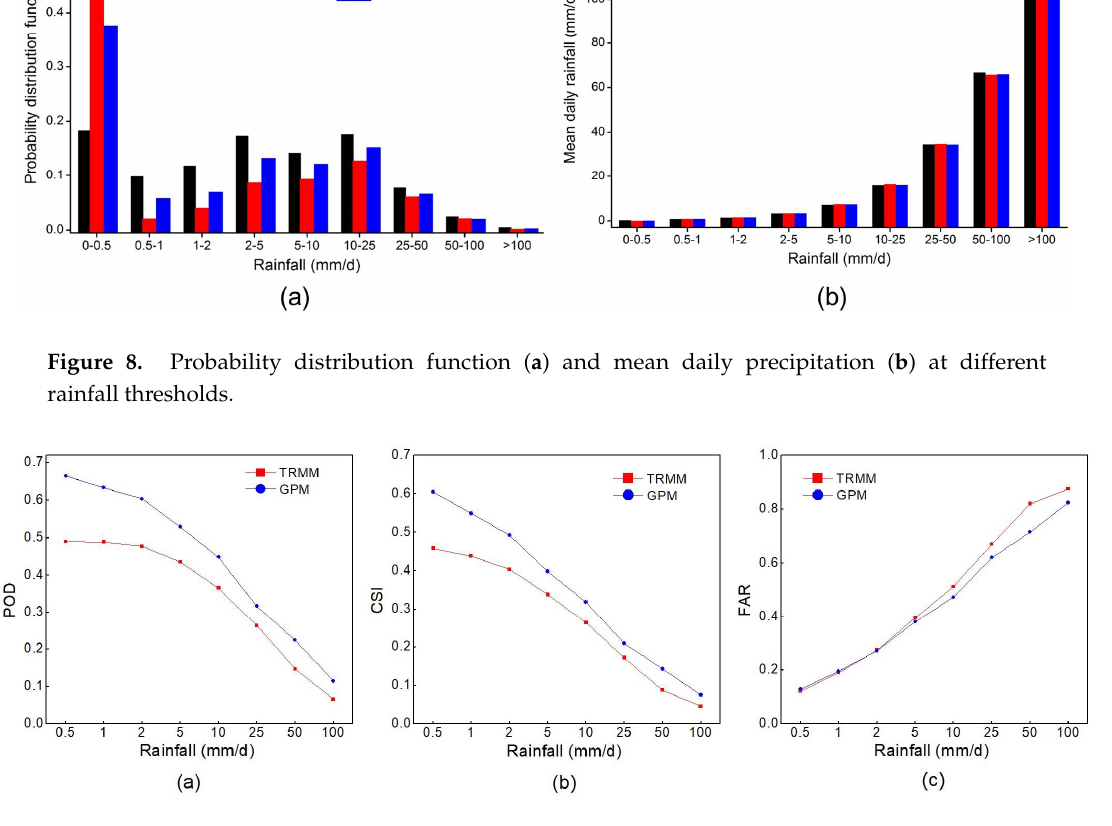
Figure 9. Daily results of three metrics for different rainfall thresholds: ( a – c ) represent POD , CSI , and FAR , respectively.